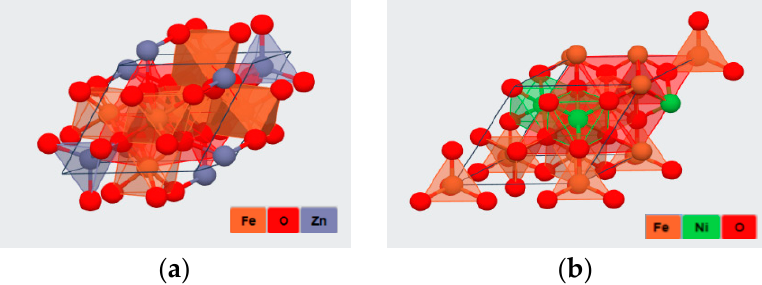
Figure 1. ( a ) Normal structure: ZnFe 2 O 4 ; ( b ) Inverse structure: NiFe 2 O 4 . The atoms are represented by spheres: Fe (orange), O (red), Zn (purple) and Ni (green).